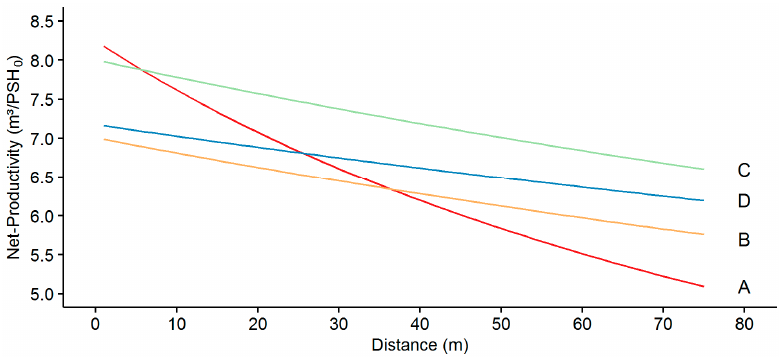
Figure 7. Standardized net-productivity (m 3 /PSH 0 ) for campaign ( A ) red, ( B ) orange, ( C ) green and ( D ) blue in dependence of increasing yarding